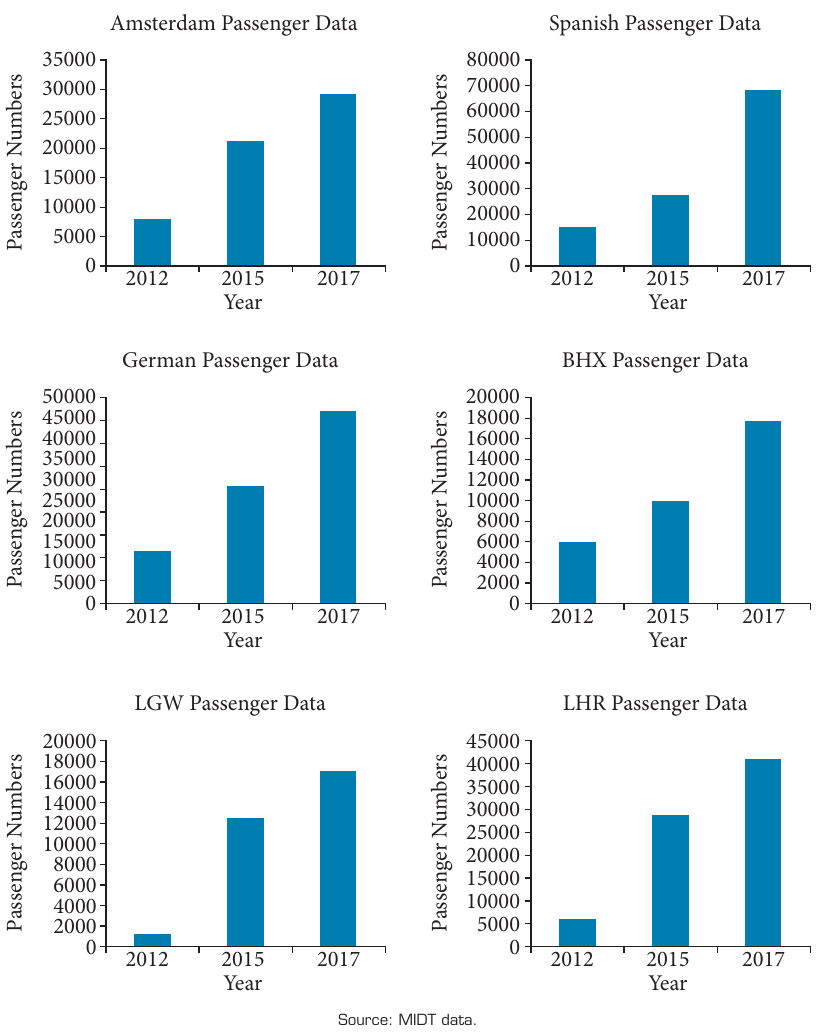
Figure 1. Aer Lingus interline passenger